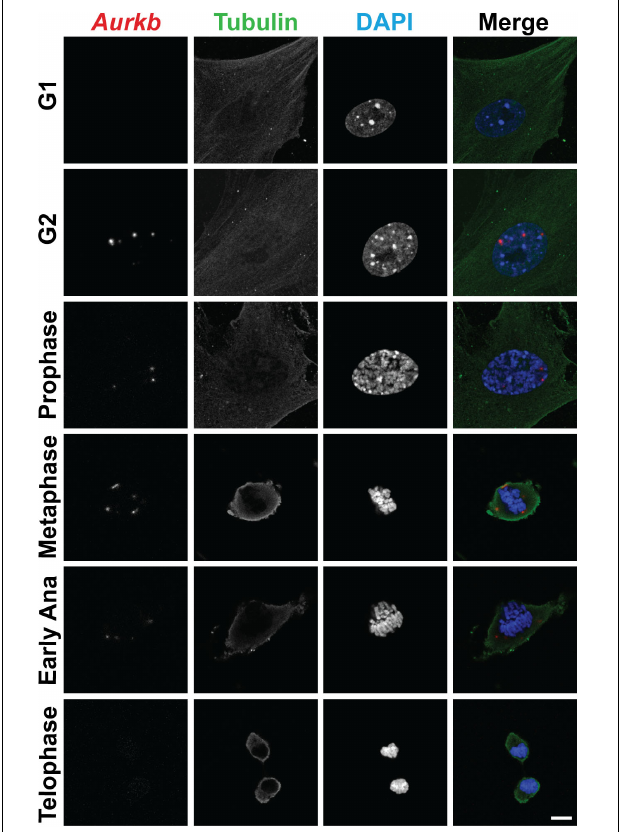
FIGURE 1 | The expression of Aurkb transcripts during the cell cycle. Double staining of RNAscope and immunofluorescence in MEFs. Bar, 10 µ m.